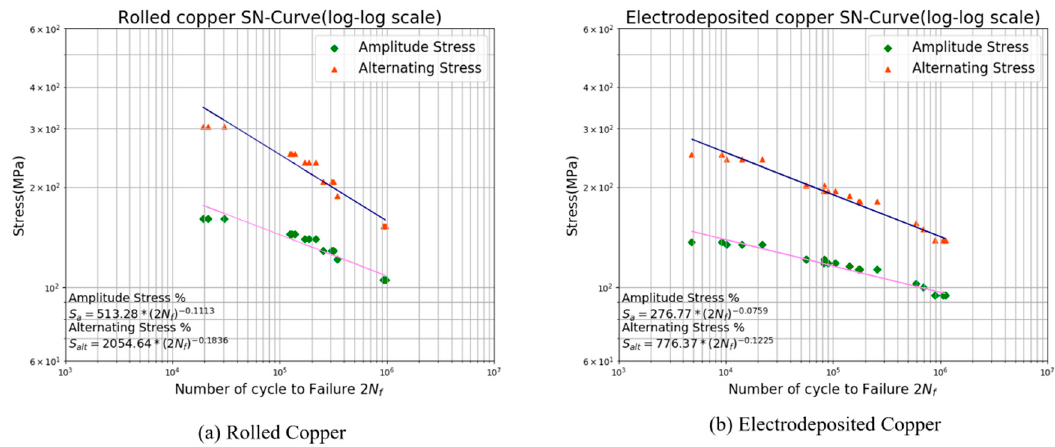
Figure 10. Stress-Fatigue life curve (S-N curve): Comparison of fatigue properties of Cu thin films depending on process method